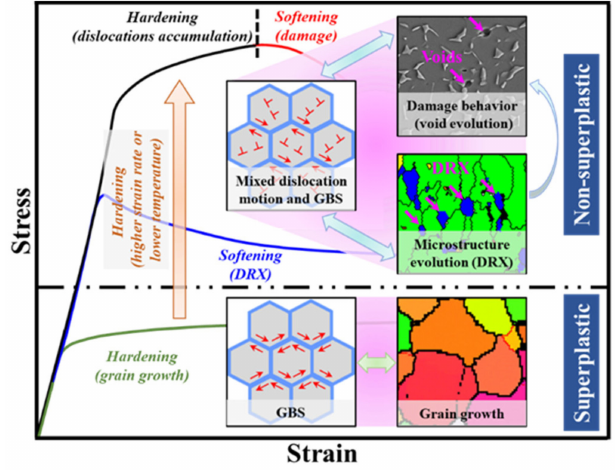
Figure 1. Interaction relationship of the microscopic heterogeneous deformation, the microstructure evolution and the damage behaviour of titanium alloys during hot deformation.